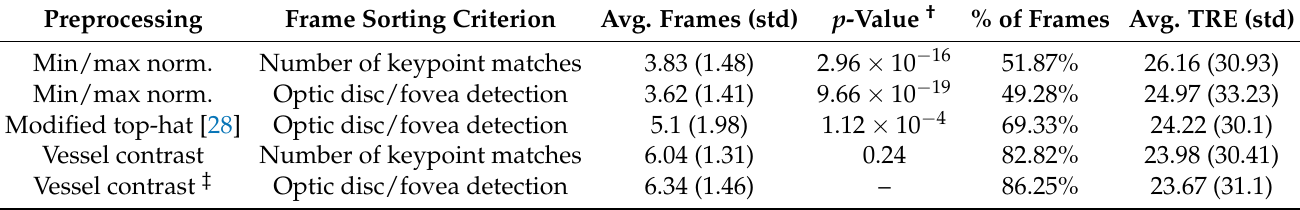
Table 1. Comparison of preprocessing frame sorting methods for constructing a photomontage on 62 image sequences. Preprocessing